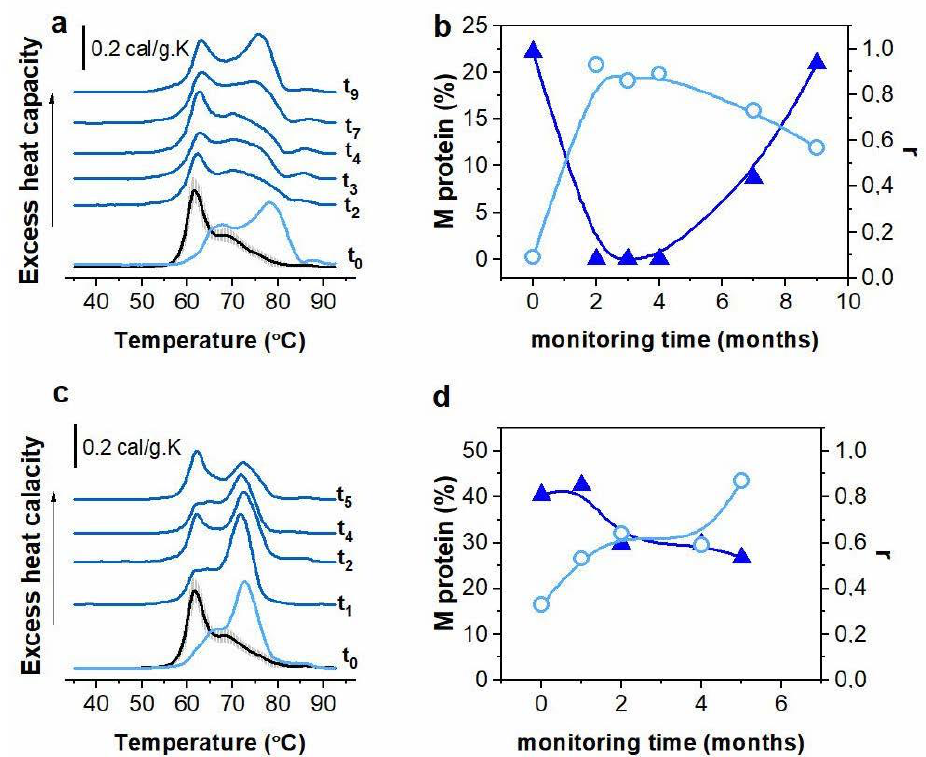
Figure 5. Selected series of calorimetric scans recorded for 2 patients monitored for 5 or 9 months: IgA MM patient before and after ASCT (t 0 — before, t i — monitoring points after transplantation, subscripts denote months after ASCT) ( a ) and IgM MM patient during the course of the applied clinical treatment (t 0 — beginning of monitoring period, the months of monitoring period are indicated as t subscript) ( c ). The mean DSC profile for healthy individuals not subjected to medical intervention is plotted in black (SD, grey shadow). Correlation between the variation in the M-protein concentration (( b , d ), blue triangles) and the shape similarity parameter r (( b , d ), light blue open circles) for the monitoring points after transplantation are shown for the two presented cases. Modified from